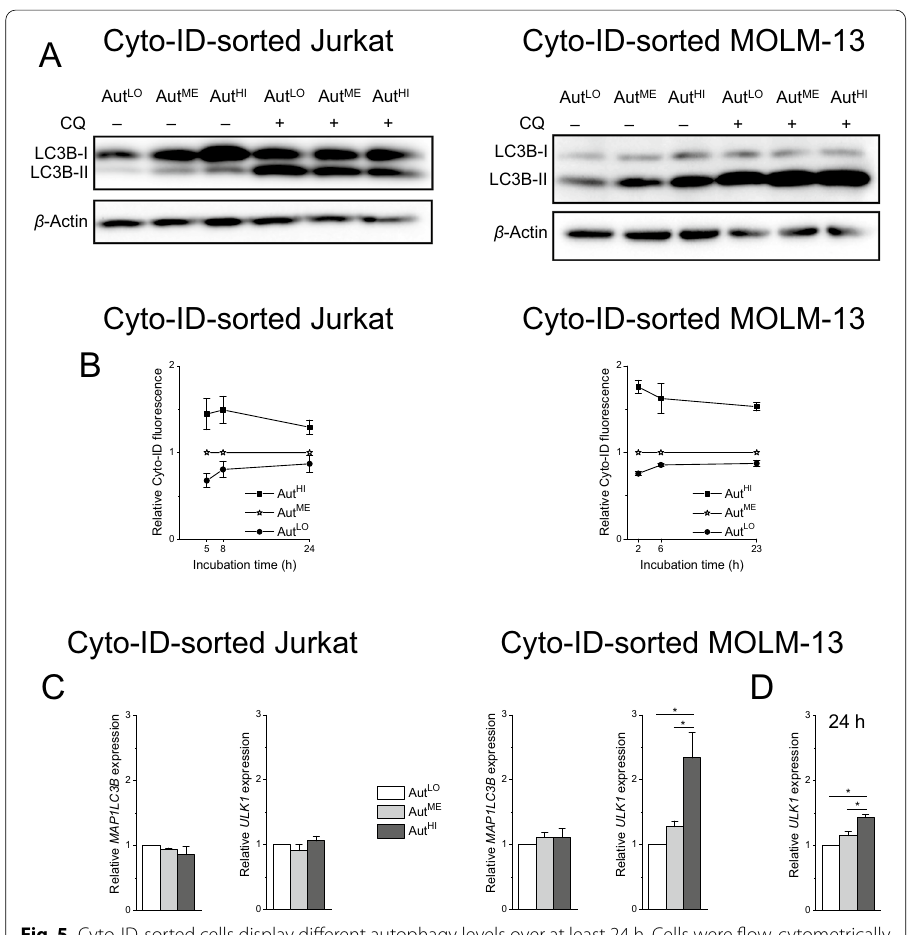
Fig. 5 Cyto‑ID‑sorted cells display different autophagy levels over at least 24 h. Cells were flow‑cytometrically sorted on the basis of their Cyto‑ID fluorescence intensity into subpopulations with low, medium, and high Cyto‑ID fluorescence (Aut LO , Aut ME and Aut HI , respectively). A Representative immunoblots of lysates from sorted cells. Lysates were prepared after 1‑h cultivation of sorted cells in the absence or presence of 10 µM CQ. B Sorted cells were incubated for the indicated times, and autophagy was determined by flow‑cytometric analysis of Cyto‑ID‑stained cells. Cyto‑ID fluorescence intensities of the three fractions were normalized to the Cyto‑ID fluorescence intensity of Aut ME . C, D RNA was prepared either approximately 1 h after sorting ( C ) or after 24‑h cultivation of sorted cells ( D ). mRNA expression levels were determined by real‑time RT‑PCR and normalized to B2M expression levels. Mean SEM of three ( C – D ) or four ( B ) ± independent measurements is shown (* P <